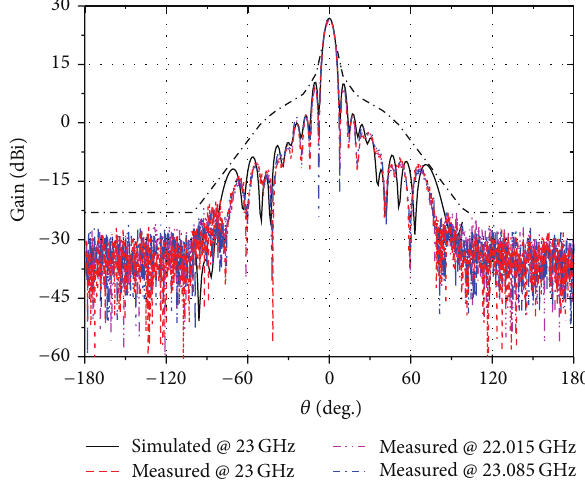
Figure 4: Simulated and measured patterns in 𝐸 -plane of the fabri- cated 16 × 22 SIW slot array